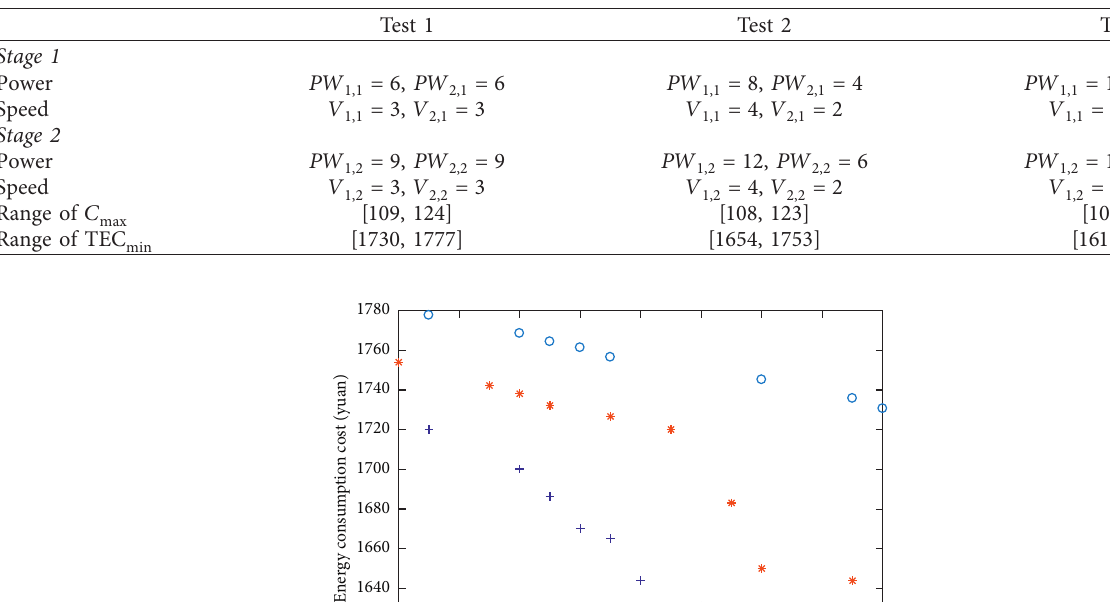
Figure 15: Relative change of makespan and total energy consumption Table 6: Test results by three different settings of power and speed.